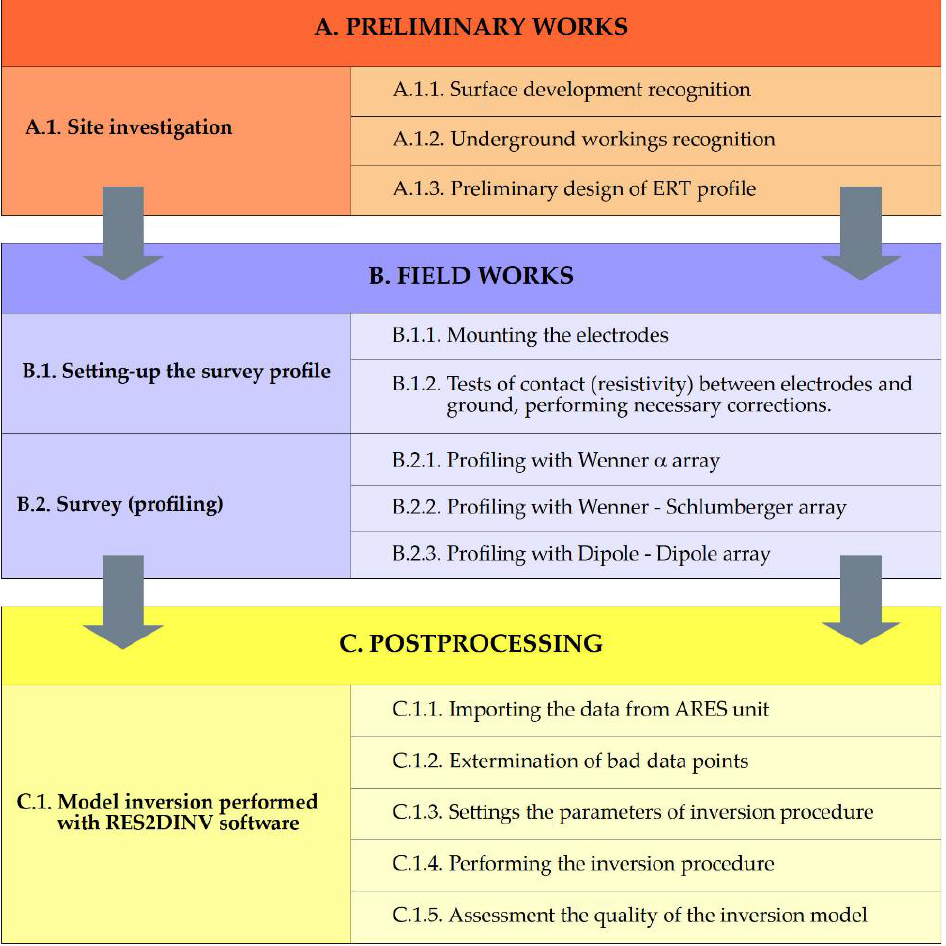
Figure 6. The flowchart of works performed during the ERT survey. The possibilities of the unconstrained location of the ERT profile line were